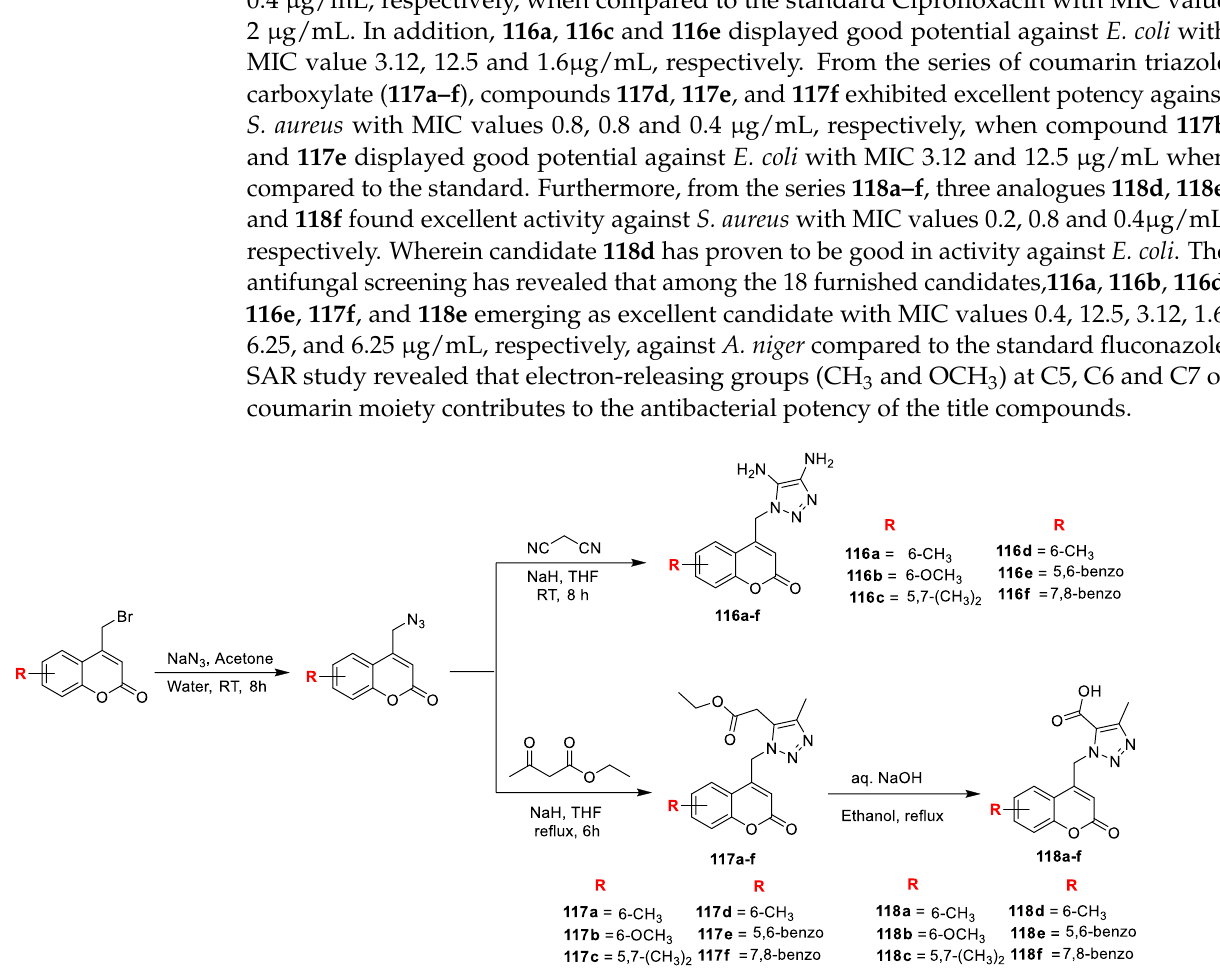
Scheme 23 . Schematic representation of 4 – substituted coumarino-1,2,3-triazole. Reproduced and adapted with permission from ref. 39. Copyright 2018,